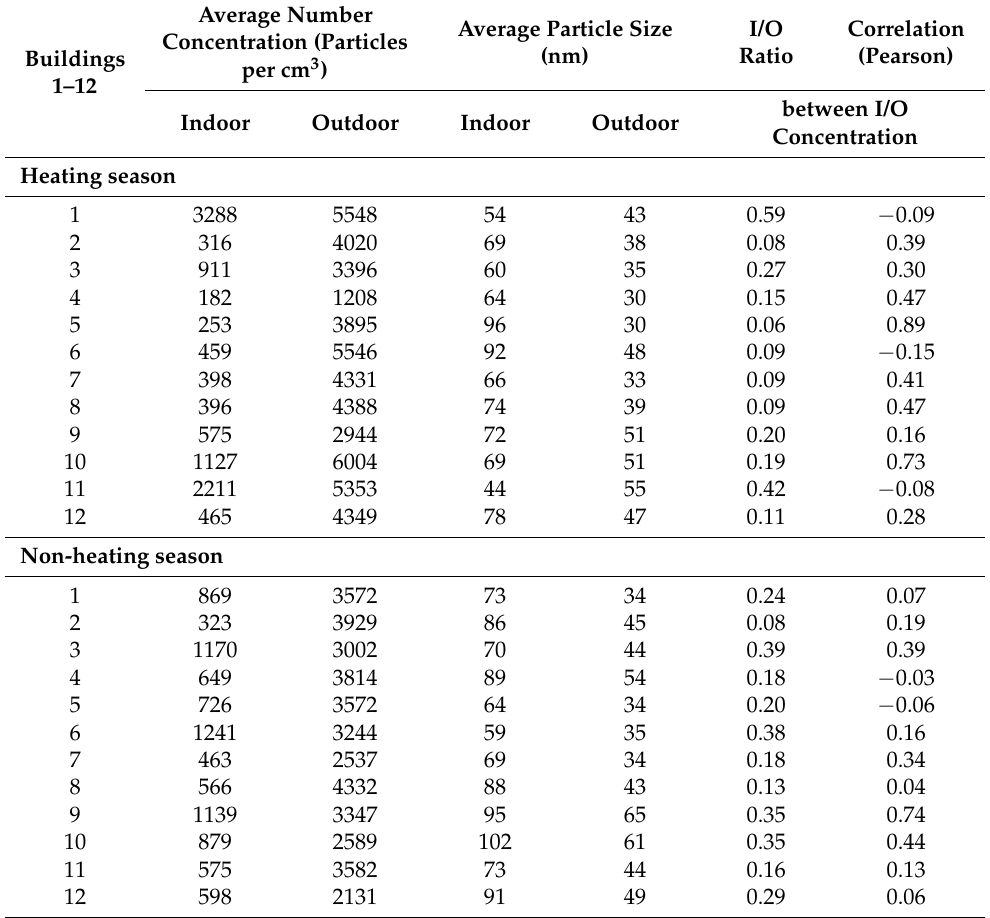
Table 2. Average number concentrations indoors and outdoors, average sizes of nanoparticles indoors and outdoors, I/O concentration ratios and correlations between indoor and outdoor concentrations in 12 office buildings in Umeå during the heating and the non-heating seasons. The buildings and their numbers are presented in Figure